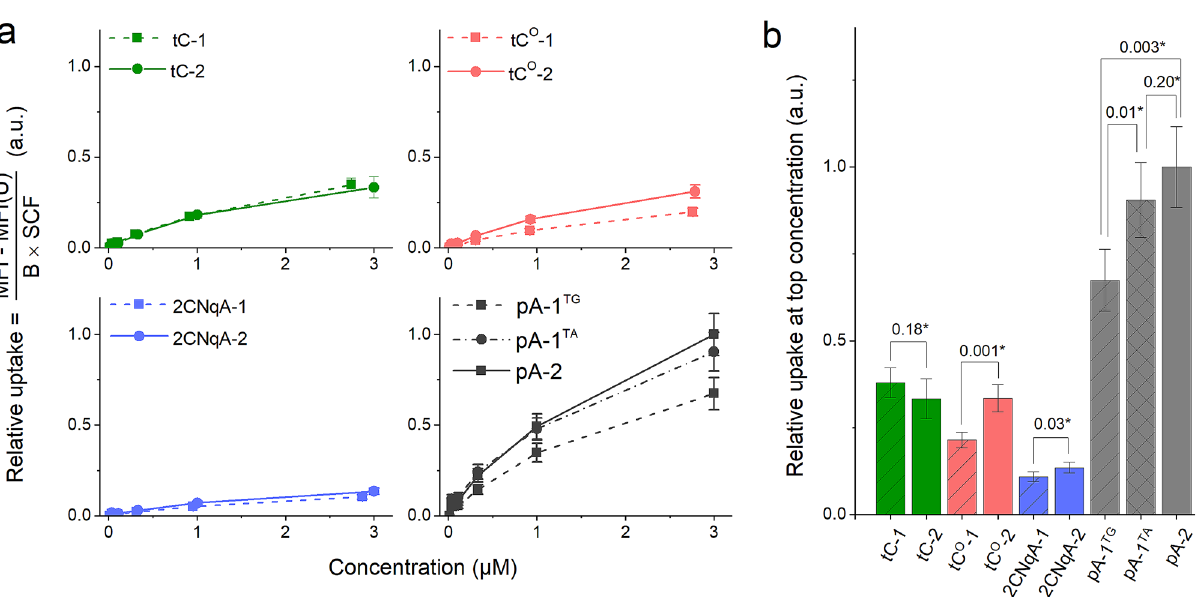
Figure 6. Quantification of gapmer uptake in HEK 293 T cells after 24 h continuous exposure, evaluated using flow cytometry. All data were collected using the same excitation power (excitation at 405 nm) and detector settings. To enable comparisons of the FBA-labeled gapmer concentrations inside cells, a relative uptake was calculated based on the observed mean fluorescence intensity (MFI, see Supplementary Fig. S24 for the untreated data). Briefly, this was achieved by ( 1 ) subtracting the corresponding MFI from the negative control (unmodified gapmer U at equal concentration), ( 2 ) dividing by the brightness of the single-stranded gapmer (B) and ( 3 ) dividing by a spectral correction factor (SCF), see supplementary Sect. 3.5 for details. ( a ) Dose-dependent relative uptake. ( b ) Relative uptake at the top concentration in ( a ). Error bars are propagated standard deviations ( N = 6) based on the cytometry- and brightness data (Supplementary Fig. S18). *Probability for equal mean from a paired sample t